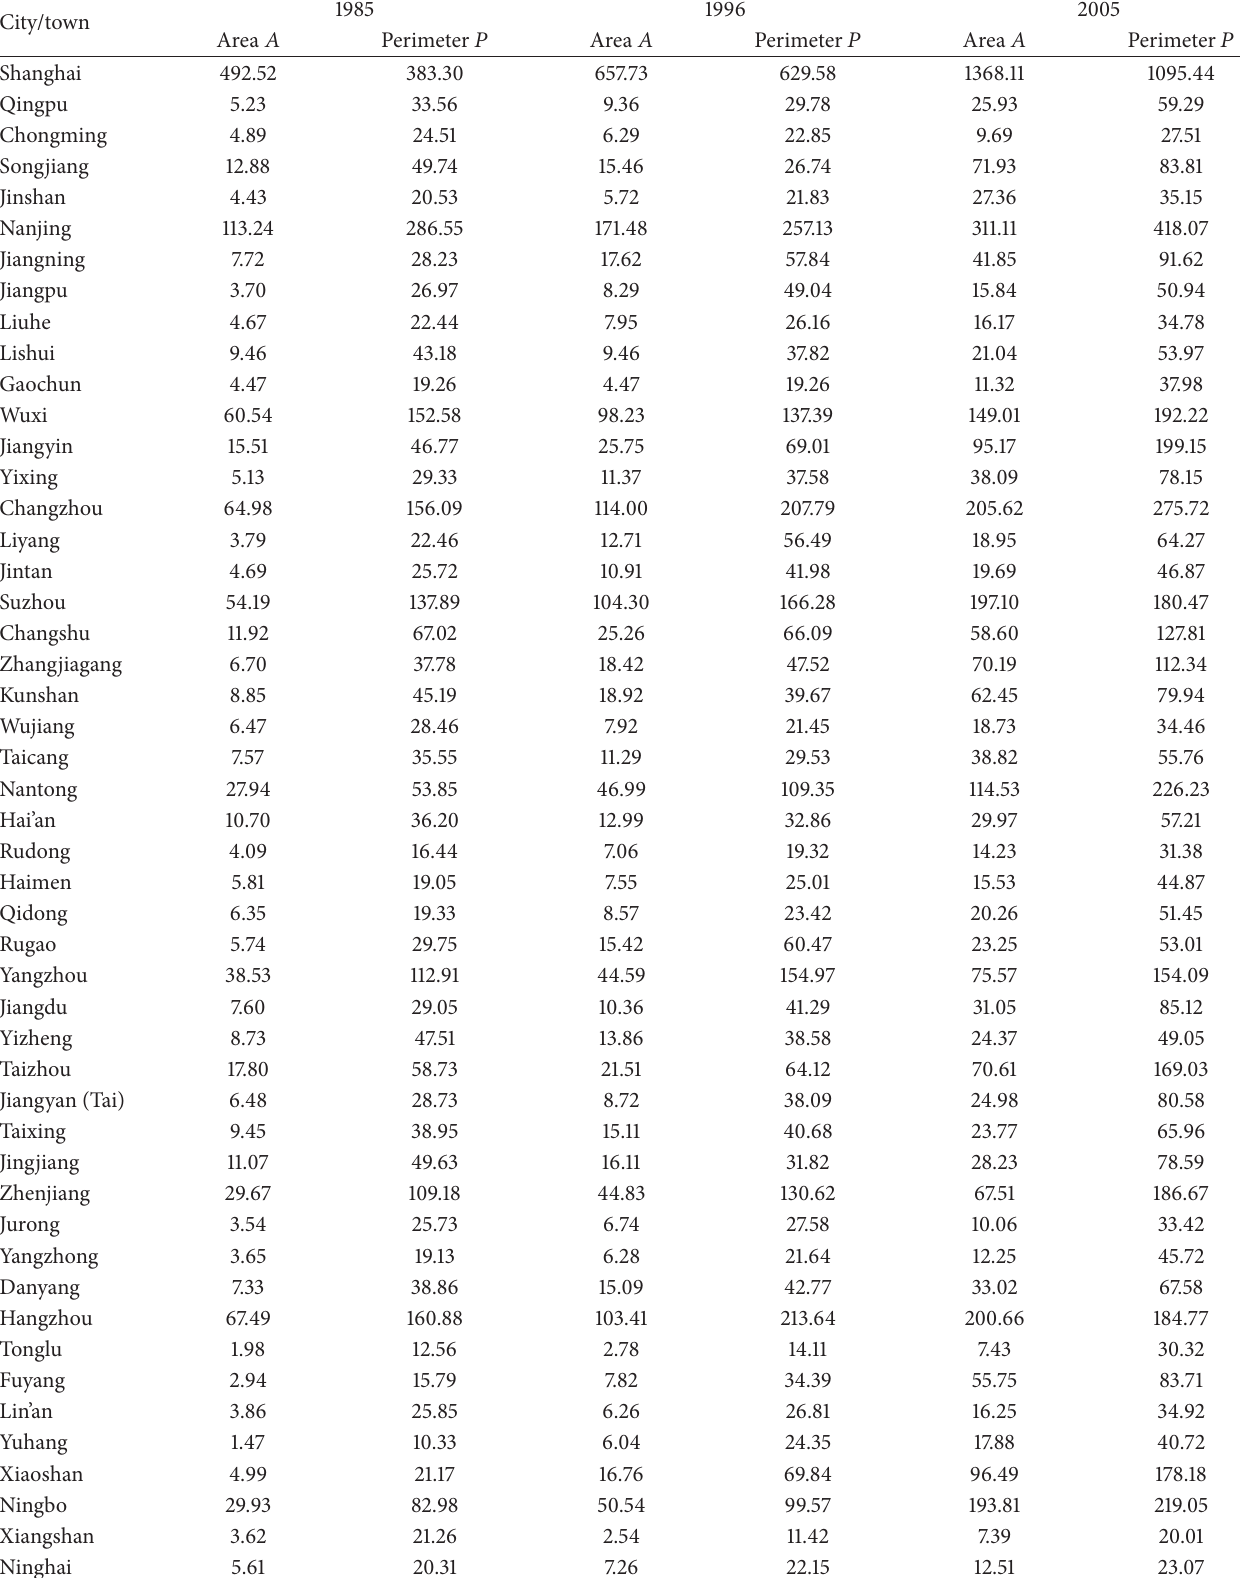
Table 1: The urban area and perimeter datasets of the cities and towns in Yangtze River Delta, China (1985–2005).